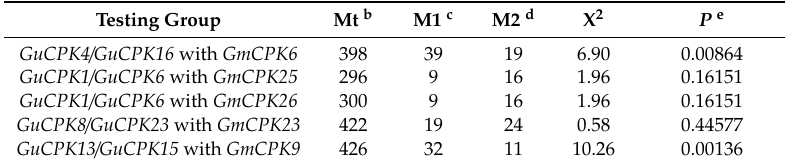
Table 2. Tajima relative rate tests of CPK gene pairs in G. uralensis a